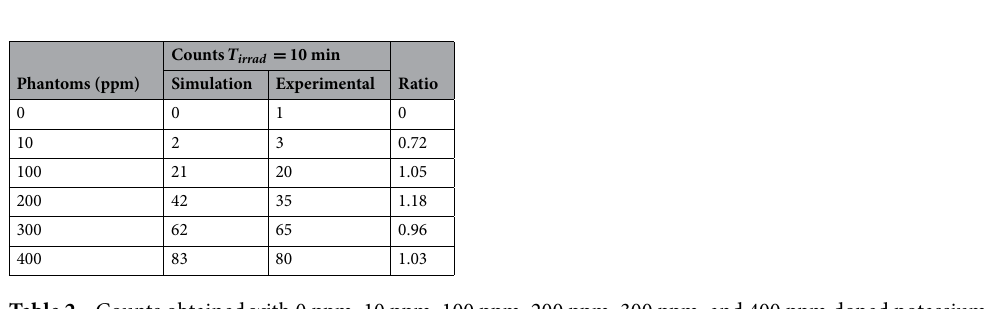
Table 2. Counts obtained with 0 ppm, 10 ppm, 100 ppm, 200 ppm, 300 ppm, and 400 ppm doped potassium (41K) phantoms obtained with MCNP simulation and experiment.